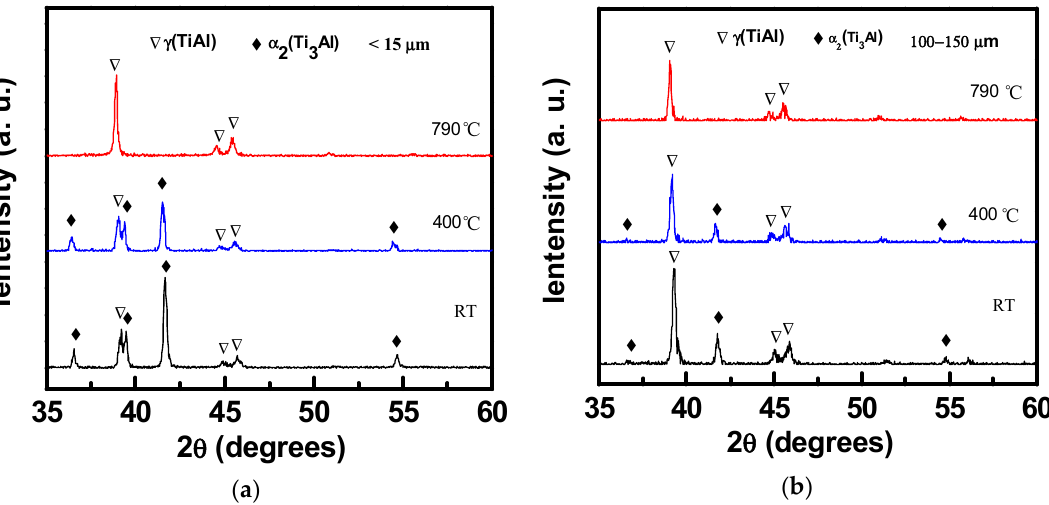
Figure 4. In situ high-temperature XRD patterns of the as-atomized high-Nb TiAl powders with different sizes: ( a ) fine size (<15 µm); ( b ) large size (100–150 µm).